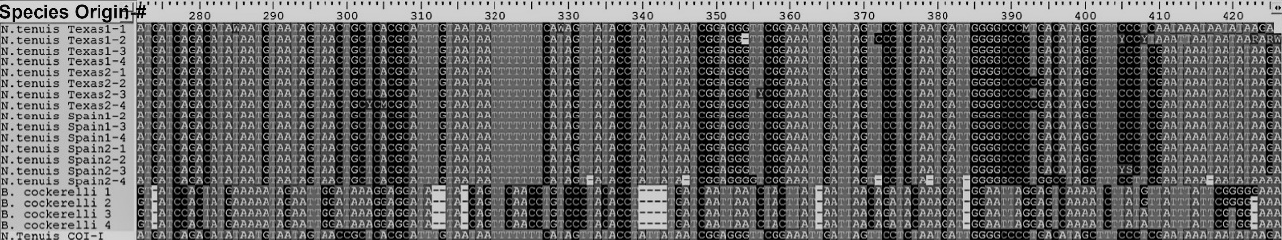
Figure 2. Alignment of sequenced mtCOI amplicons.